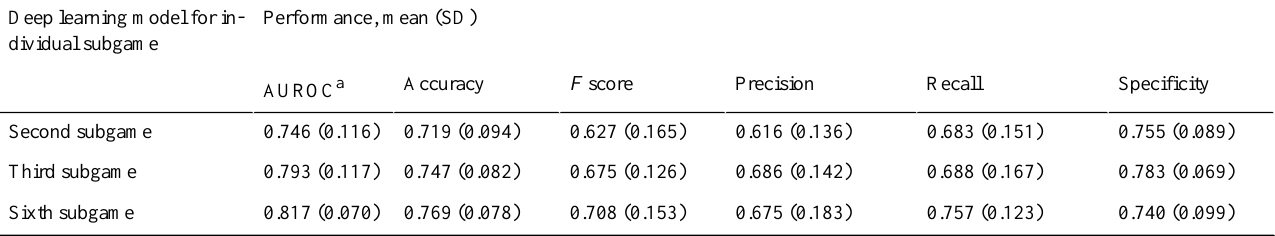
Table 3. Average model performance result by 10-fold cross-validation in each drag-and-drop subgame. Performance, mean (SD)Deep learning model for in-